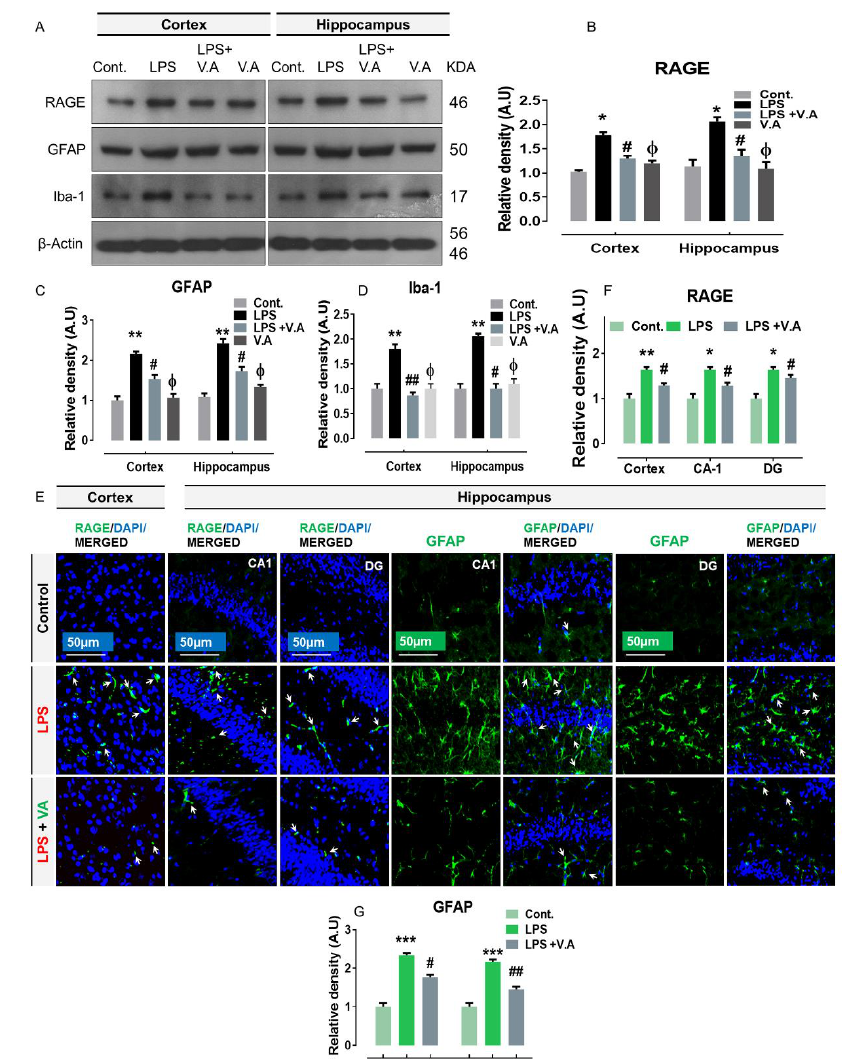
Figure 1. Vanillic acid treatment inhibited lipopolysaccharides (LPS)-activated receptor for advanced glycation endproducts (RAGE)/gliosis (microglia and astrocytes) in Mice Brain. ( A – D ) the western blot bands of the RAGE, glial fibrillary acidic protein (GFAP), and ionized calcium-binding adaptor molecule 1 (Iba-1) antibodies along with their relative histograms indicating their protein expression level in the cortex and hippocampus of mice brain. The western blot bands were cropped and quantified using ImageJ software, and the differences are shown in the histogram. The relative density values were expressed in comparison with control in arbitrary units (A.U). All the values were taken as the mean ± SEM of three repeated/independent experiments for the respective indicated protein. As a loading control, an anti-β-actin antibody was used. n = 8 mice/group, and the number (N) of experiments performed = 3. ( E – G ) the representative photomicrographs of immunofluorescence staining in different regions represent the immunoreactivity of RAGE (cortex, CA1, and dentate gyrus (DG) region) and GFAP (CA1 and DG) along with its relative histograms in various experimental brain groups (green, fluorescein isothiocyanate (FITC); blue, 4′, 6′-diamidino-2-phenylindole (DAPI)). White small arrows indicated the desired signals of the tested antibody. The relative integrated density values were expressed in comparison with control in A.U. All values were taken as the means ( ± S.E.M) for the respective indicated proteins. For nucleus staining, DAPI (blue) was used. n = 8 mice/group, and the number (N) of experiments = N = 3. Magnification = 10 × . Scale bar; cortices/DG hippocampal regions = 50 µ m. Asterisk sign (*) indicated significant difference from the normal saline-treated (Cont.) group; hash sign (#) indicated significant difference from LPS-alone treated group; while the phi sign ( Φ ) indicated no significance from normal saline-treated (Cont.) group. Significance: * # = p ≤ 0.05, ** ## = p ≤ 0.01, and *** = p ≤